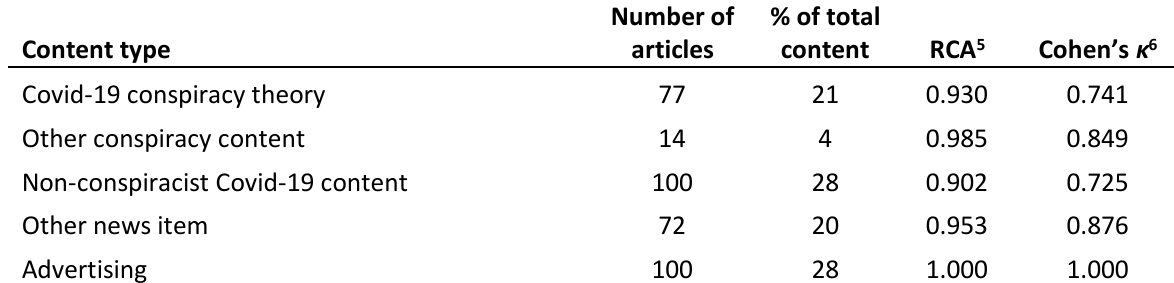
Table 1. Types of content in The Light (all